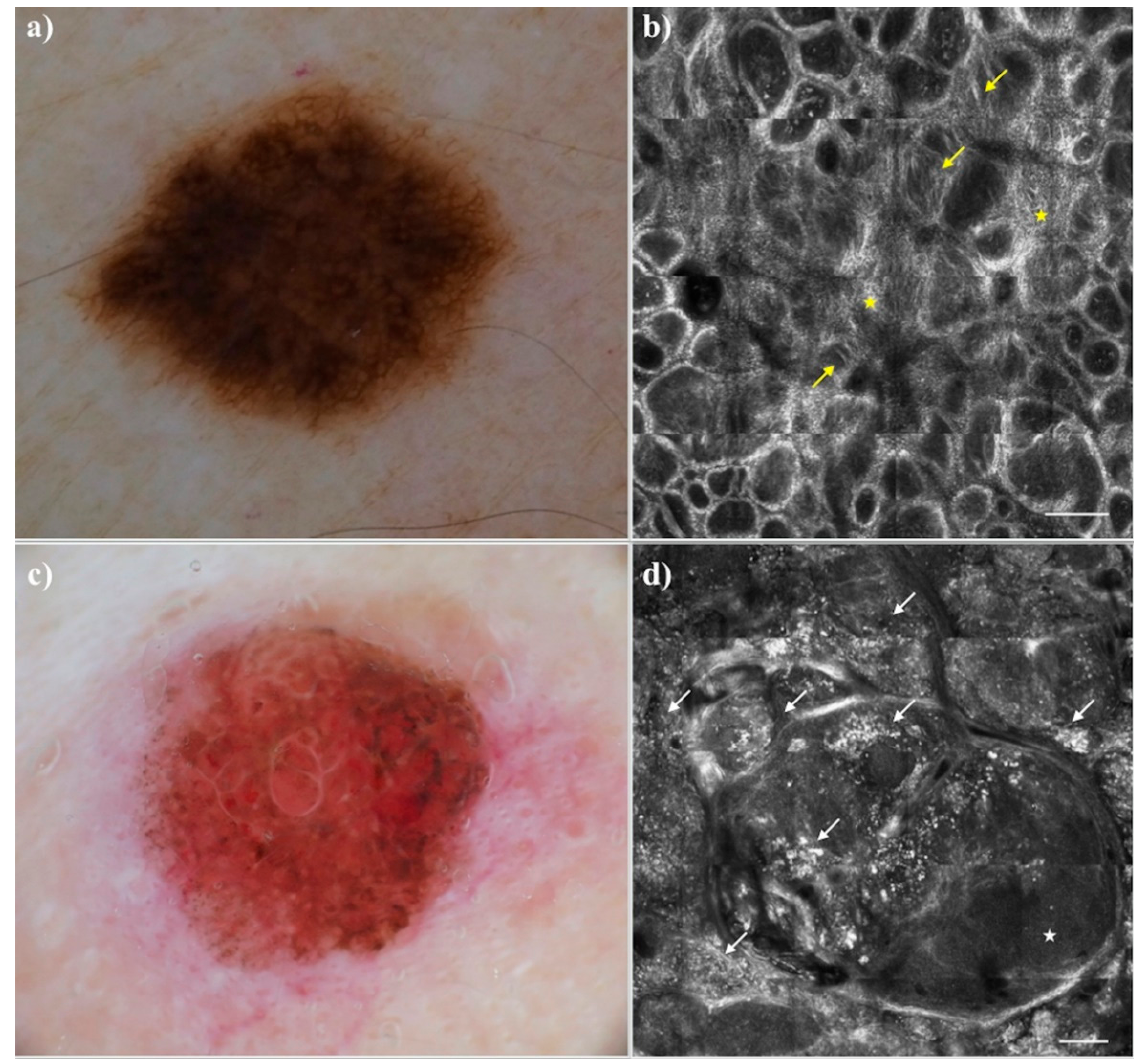
Figure 2. ( a ) Dermoscopy of a melanoma in situ. ( b ) In vivo reflectance confocal microscopy showing several pagetoid cells (yellow stars) at the epidermal level and atypical cells at dermo-epidermal junction (yellow arrows). Scale bar 200 µ m. ( c ) Dermoscopy of a melanoma, 5.3 mm Breslow thickness. ( d ) In vivo reflectance confocal microscopy showing atypical melanocytes (white arrows), predominantly organized in nests and cerebriform nests (white star). Scale bar 200 μ m.